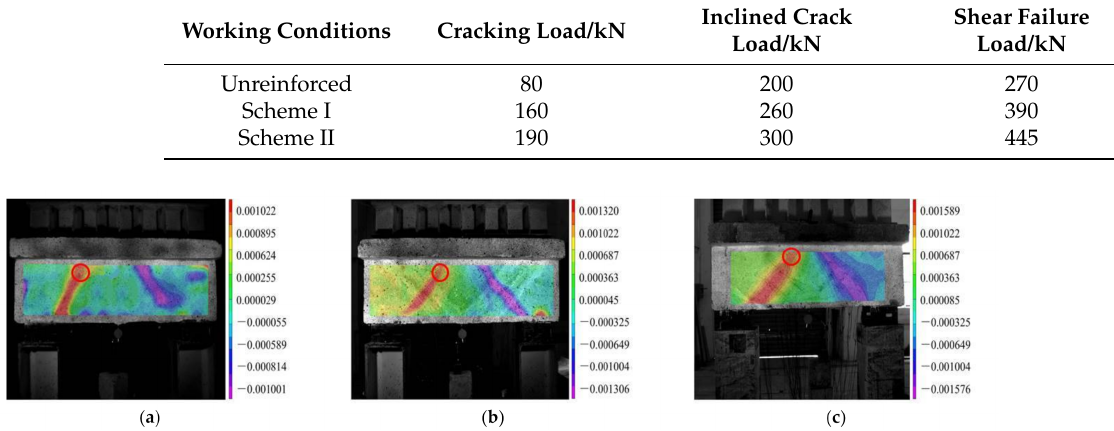
Figure 14. Failure strain distribution in different beams: ( a ) Failure strain distribution of unreinforced beam; ( b ) Failure strain distribution in Scheme I; ( c ) Failure strain distribution in Scheme II.